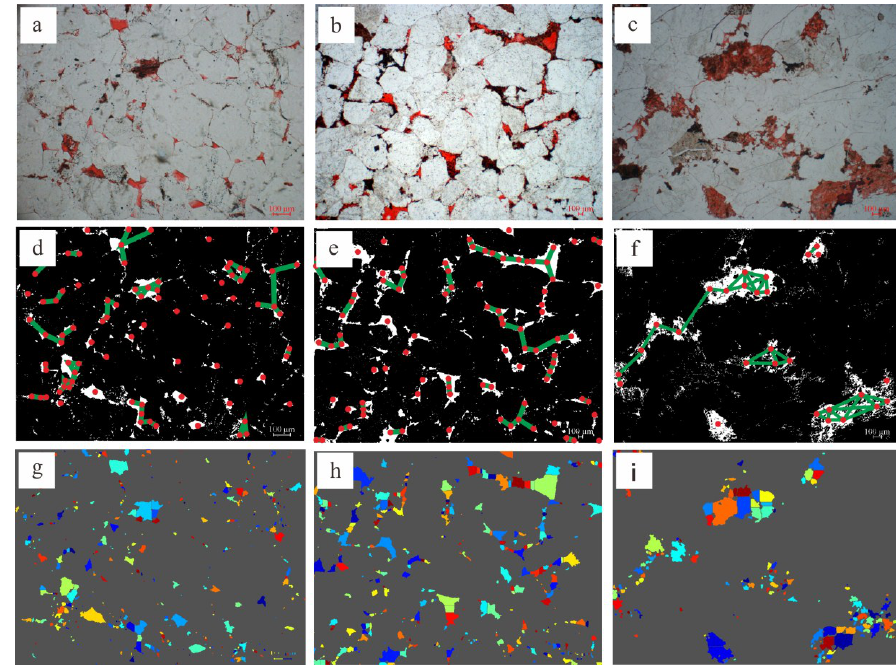
Figure 3. The main types of pore, binary image, and identified binary images of the He8 section of the study area. ( a ) Y488, intergranular pores of tight sandstones, ×5; ( b ) Y482, dissolved pores of tight sandstone, ×5; ( c ) Y391, intercrystalline pore of kaolinite, ×5; ( d ) binary images of intergranular pores and coordinate bonds; ( e ) binary images of dissolved pores and coordinate bonds; ( f ) binary images of intercrystalline pore of kaolinite and coordinate bonds; ( g ) distribution of intergranular pores identified by the function ‘bwlabel’; ( h ) distribution of dissolved pores identified by the function ‘bwlabel’; ( i ) distribution of intercrystalline pore of kaolinite identified by the function ‘bwlabel’.